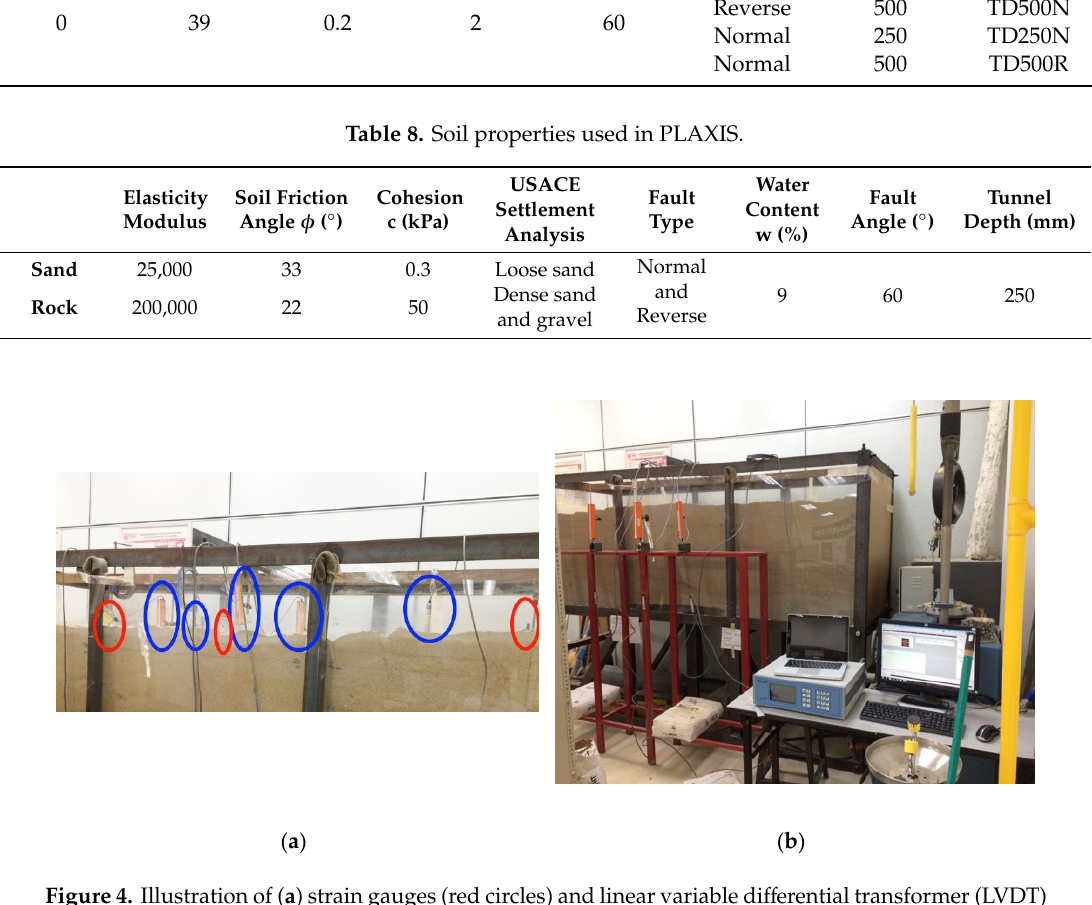
Figure 4. Illustration of ( a ) strain gauges (red circles) and linear variable differential transformer (LVDT) (blue circles), and ( b ) computer and data